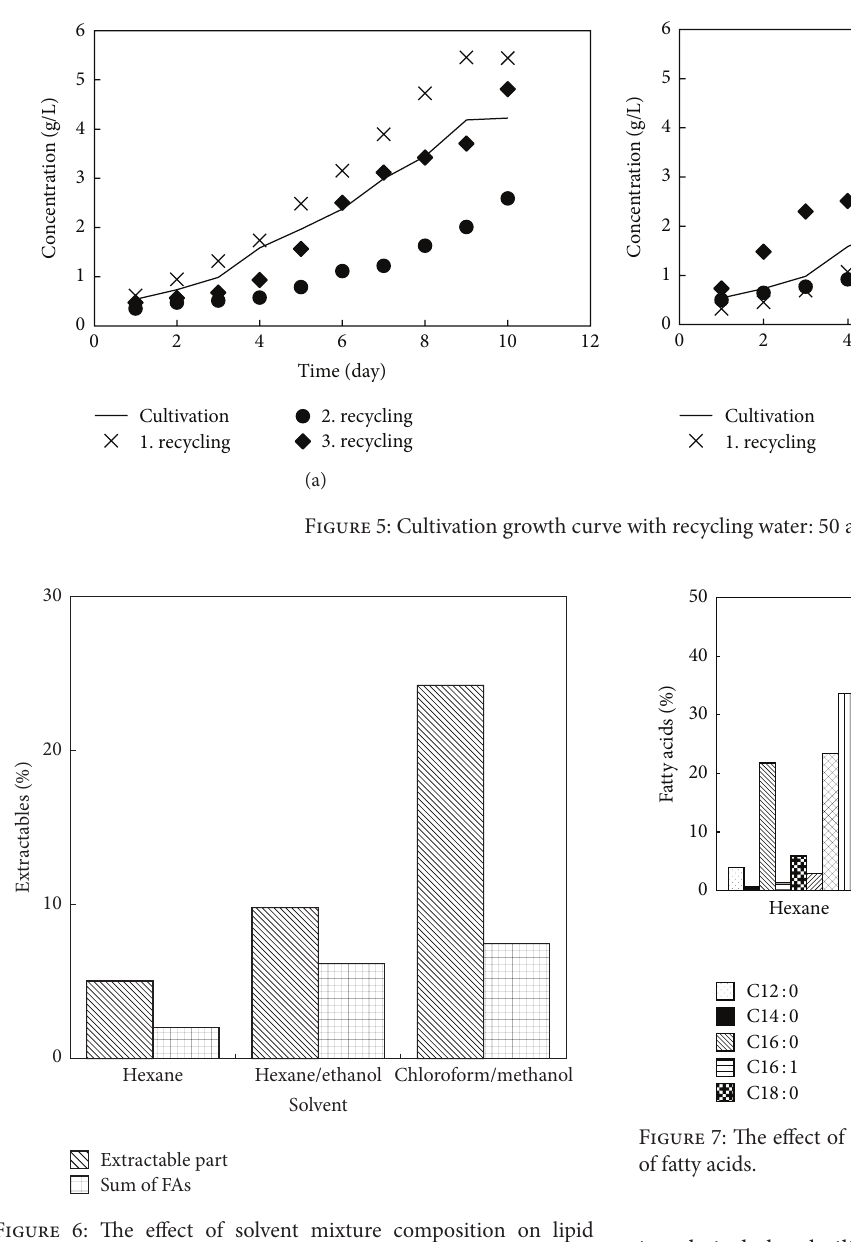
Figure 6: The effect of solvent mixture composition on lipid (extractable part) and sum of FAs content related to dry matter.